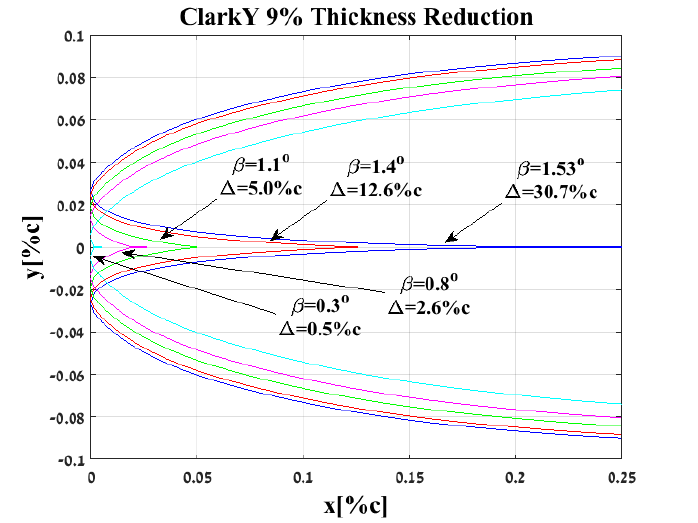
Figure 19. Visualization of thickness reduction as a mean to reduce leading edge